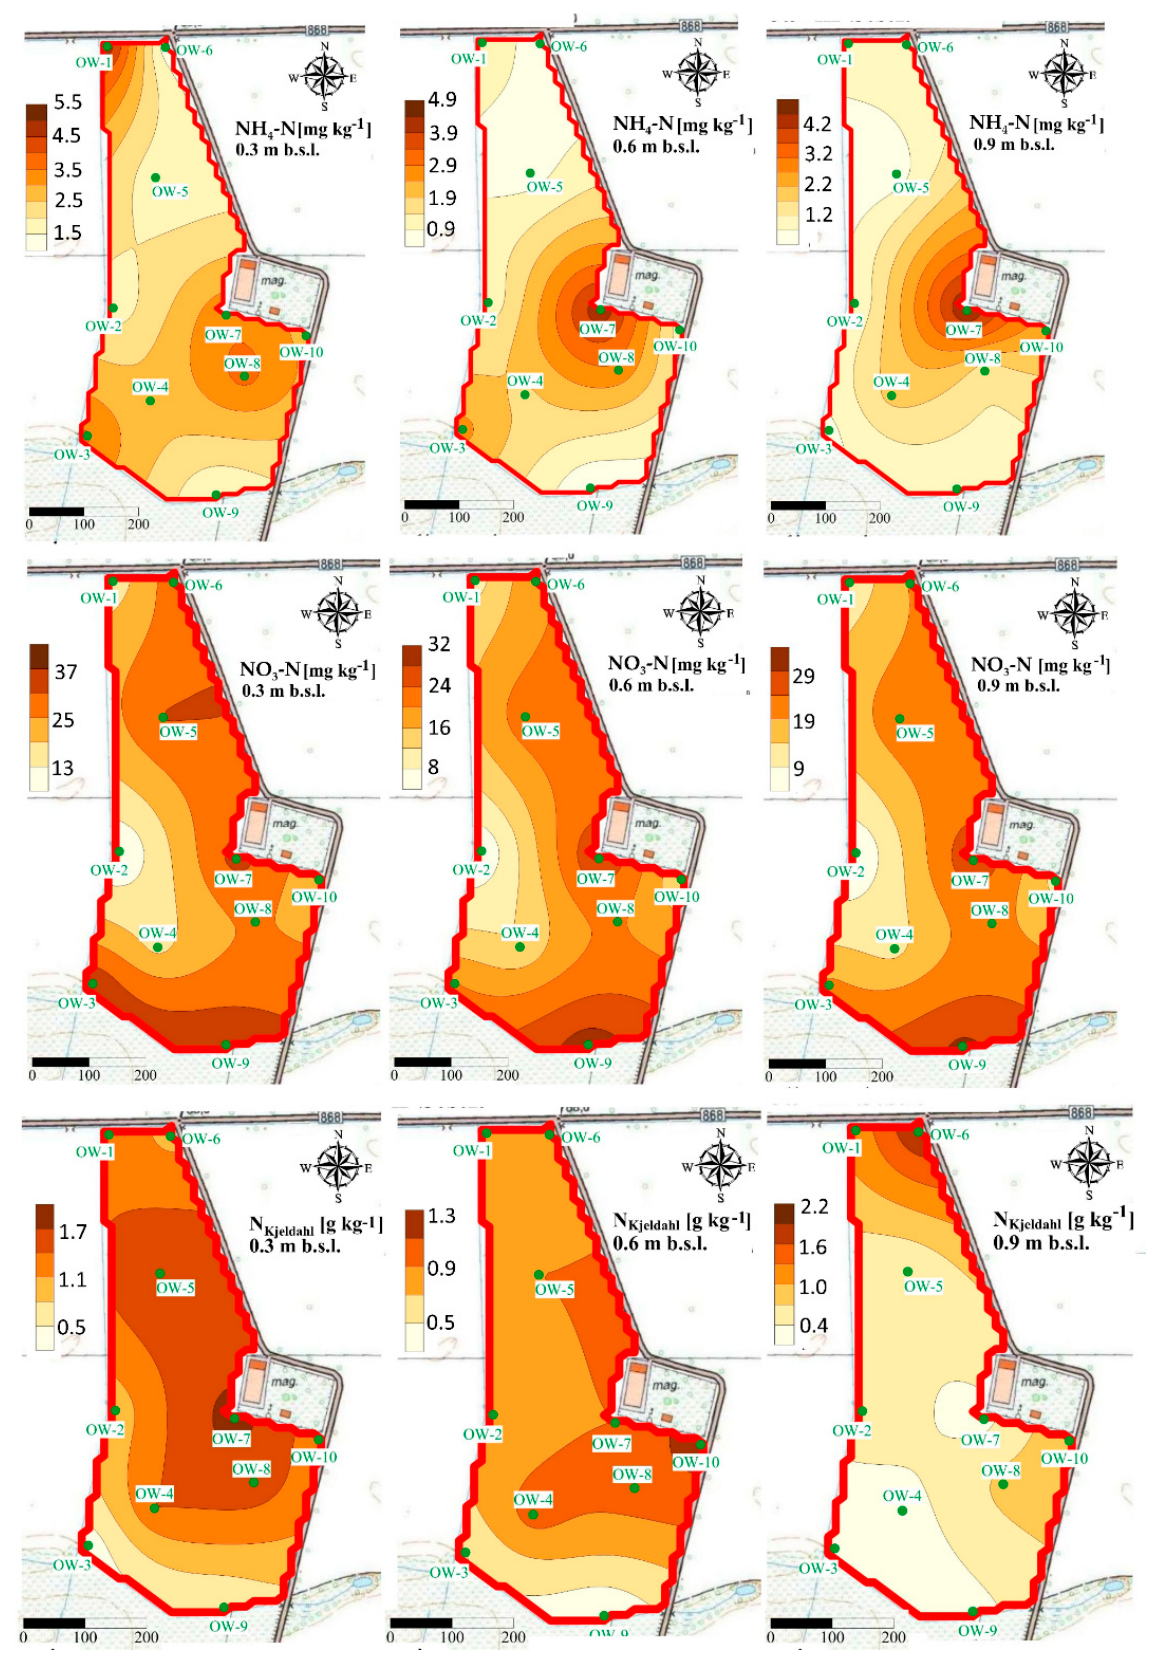
Figure 12. Spatial distribution of ammonium, nitrate, and N Kjeldahl in soil at the C experimental after UNI fertilization.